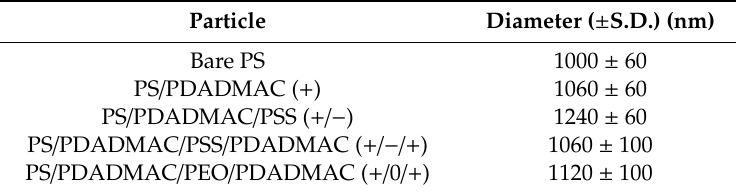
Figure 8. High-resolution transmission electron microscopy (HR-TEM) pictures of the bare and coated latex particles. latex particles. Table 1. Average ( ± S.D.) particle diameters of the latex particles